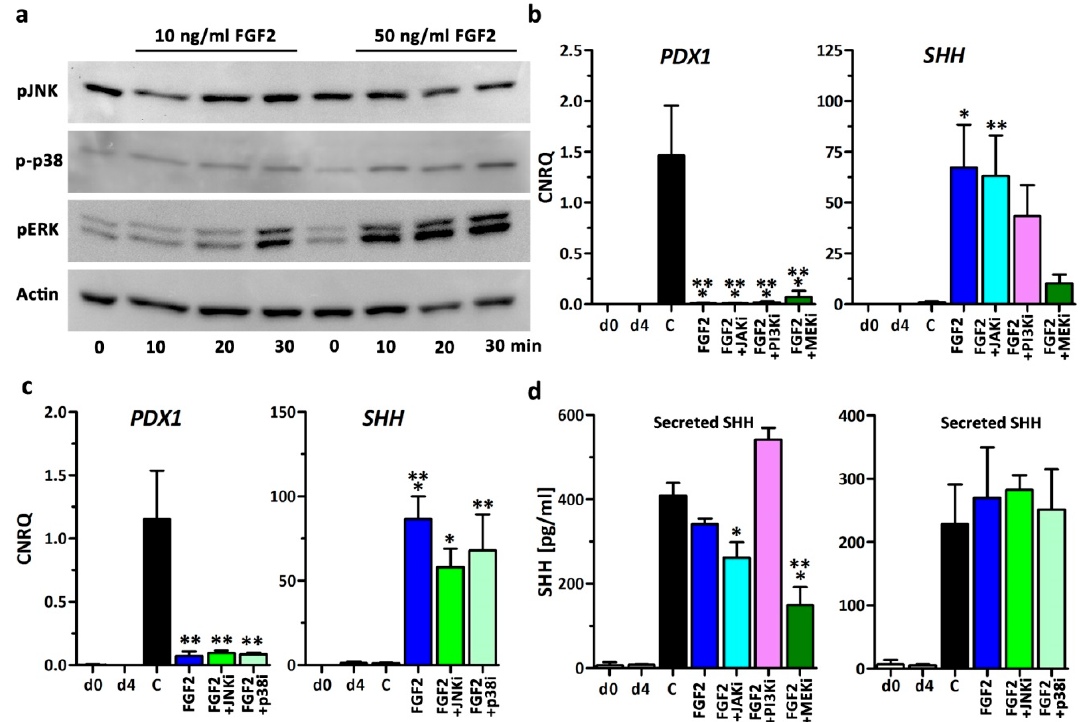
Figure 3. Small molecule inhibition of FGF2-signalling. ( a ) Analysis of JNK, ERK and p38 protein phosphorylation by Western blot after incubation of definitive endoderm cells at d4 cultured in stage 2 medium supplemented with 10 or 50 ng/µl FGF2 for 0, 10, 20, and 30 min, respectively. ( b , c ) Gene expression changes of PDX1 and sonic hedgehog ( SHH) at d8 after treatment with 50 ng/mL FGF2 and small molecule inhibitors of Janus kinase/signal transducer and activator of transcription (JAK/Stat), PI3K, MEK, JNK, and p38. Values are means ± SEM, n = 3–5. C = control without growth factors. ** = p ≤ 0.001, ** = p ≤ 0.01, * = p ≤ 0.05 compared to control, ANOVA plus Dunnett’s post-test. ( d ) Measurement of secreted SHH in the media supernatants by ELISA. The cells were differentiated with 50 ng/mL FGF2 plus small molecule inhibitors of PI3K-, JAK/Stat1-, MEK/ERK-, JNK-, and p38-signaling to block the FGF signaling downstream of the receptor. Data are presented as means ± SEM, n = 3–6 and represent the secretory capacity of 24 h. *** = p ≤ 0.001, * = p ≤ 0.05 compared to control, ANOVA plus Dunnett’s post-test.